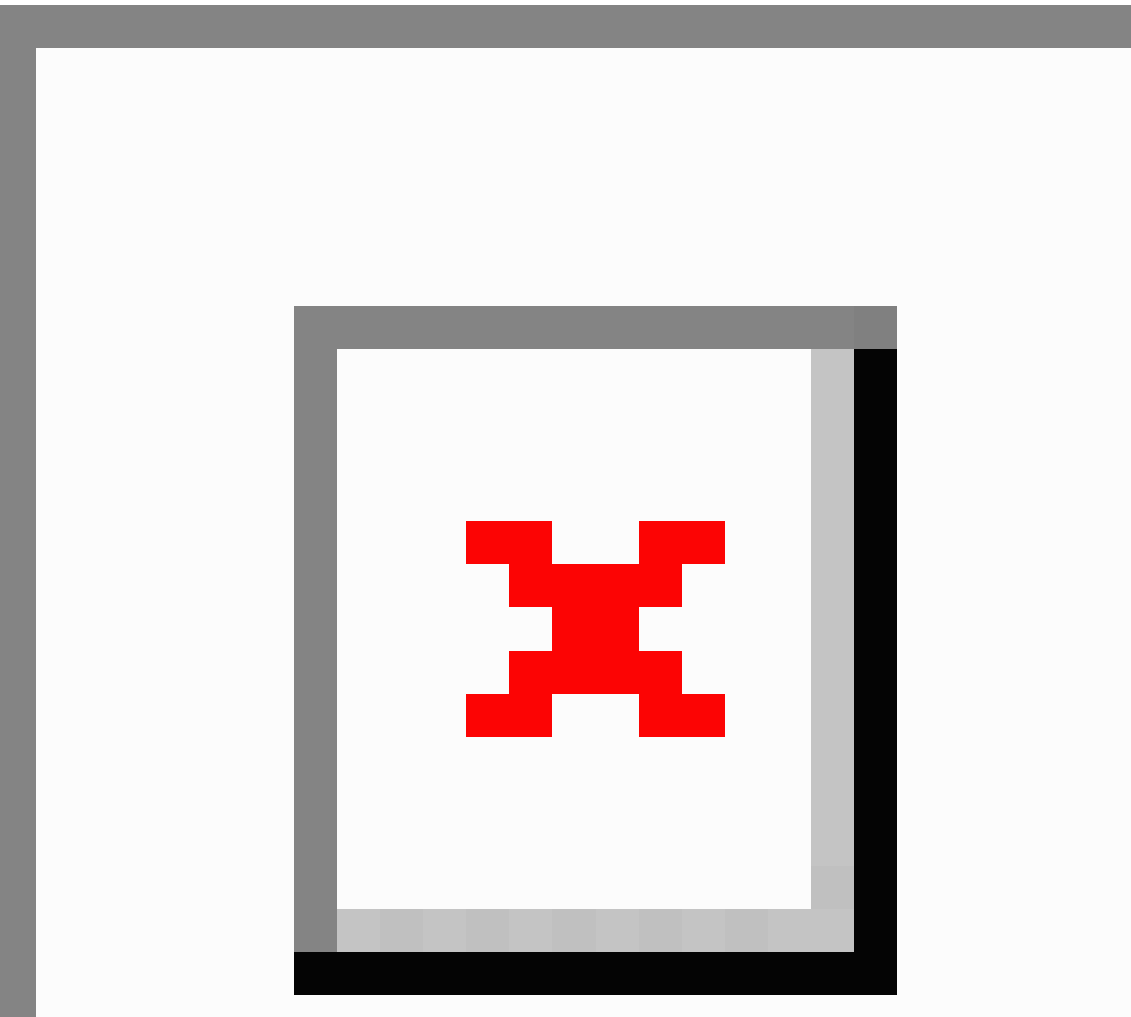
Figure 5. Screenshot of Progress webpage with Cost Savings Calculator for participants who reported that they had quit using tobacco. Participants could select money saved, smoke-free breaths, or time